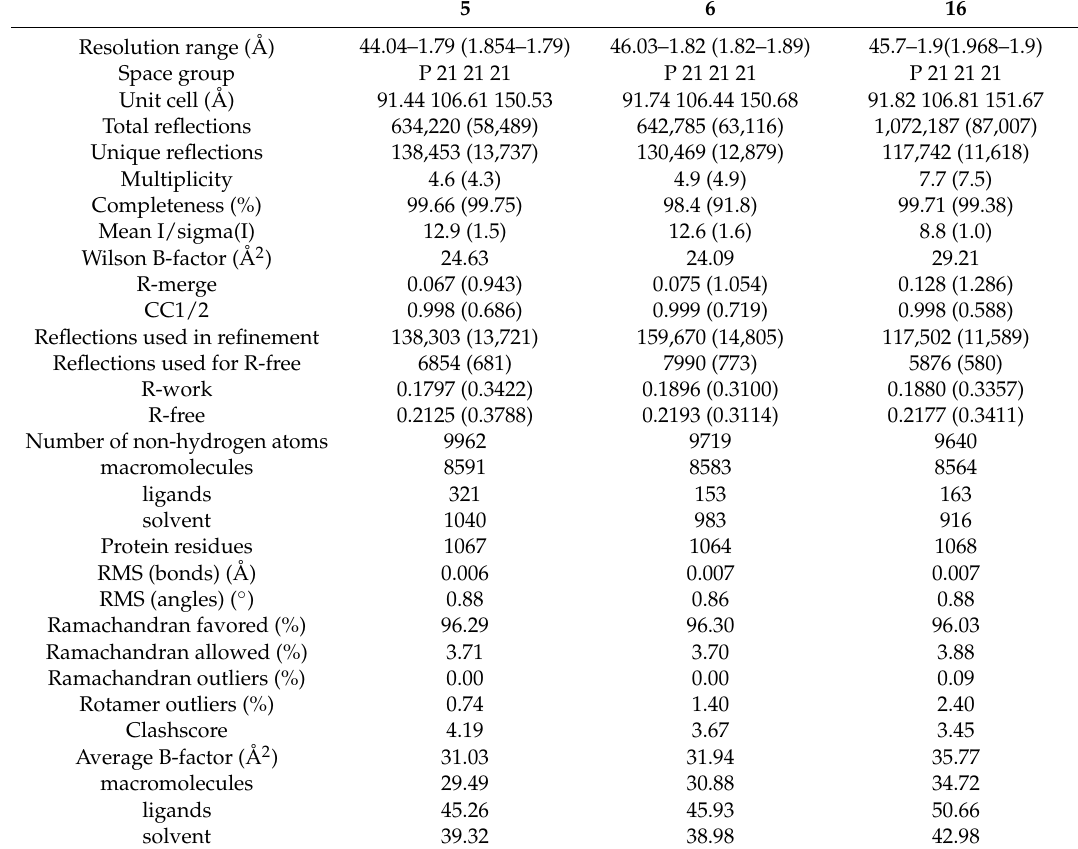
Table 3. Data collection and refinement statistics.